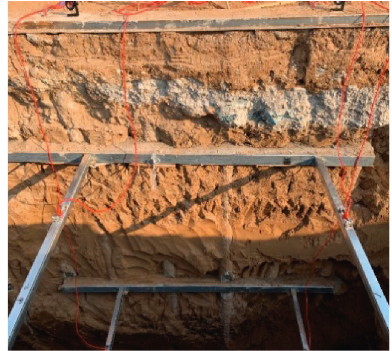
Figure 6: Installation of strain gauge.